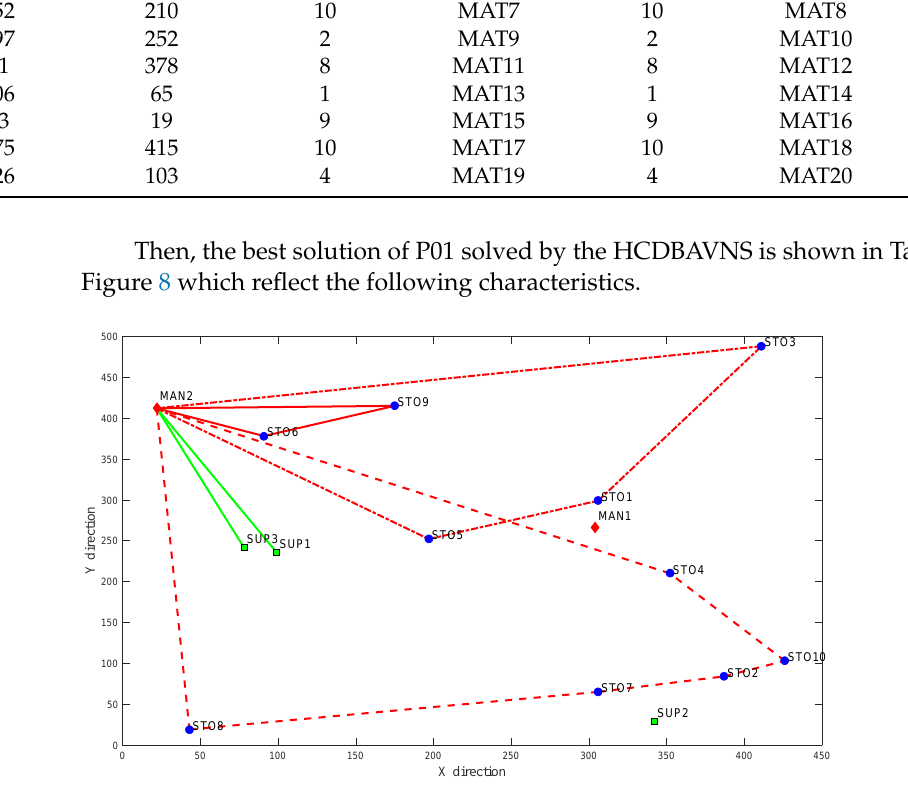
Figure 8. The schematic diagram of optimal solutions of P01 by HCDBAVNS. Table 9. Warehouses served by suppliers in the optimal solution of P01 by